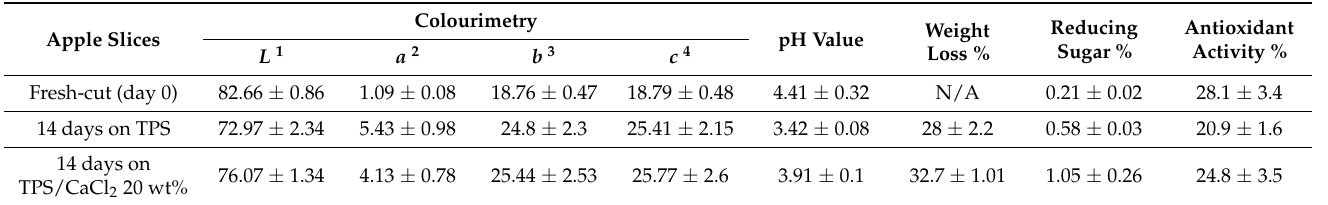
Table 1. Colourimetry results and physicochemical analysis (pH, weight loss, reducing sugars, antioxidant activity) of fresh-cut apple slices determined after 14 days of contact with TPS and TPS/CaCl 2 20 wt%